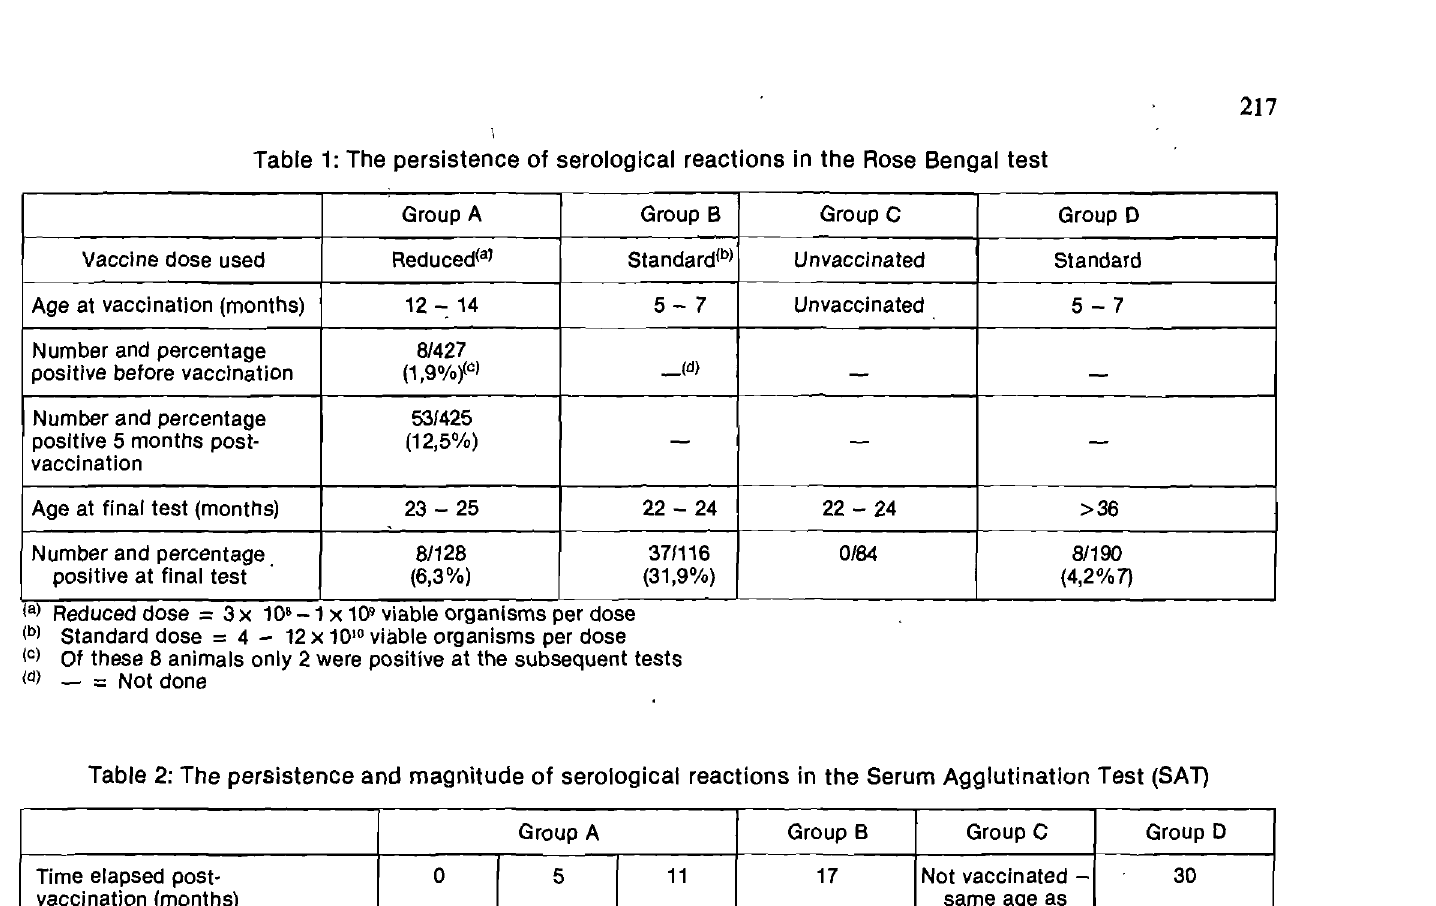
Table 1: The persistence of serological reactions in the Rose Bengal test